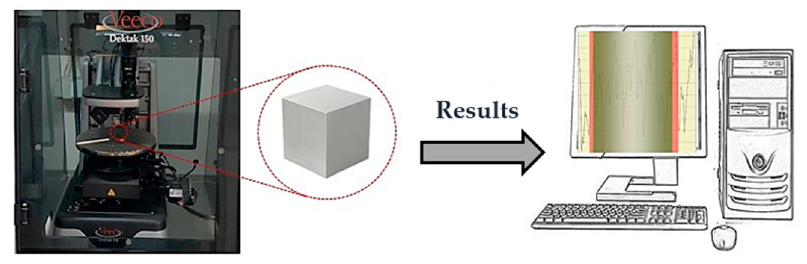
Figure 2. Experimental setup for roughness measurements.